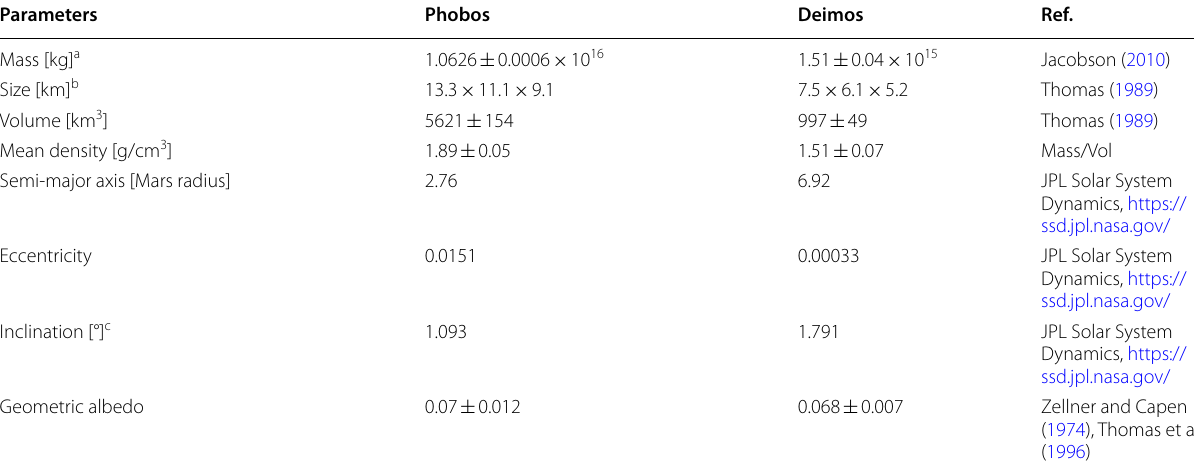
Table 1 Major properties of the Martian